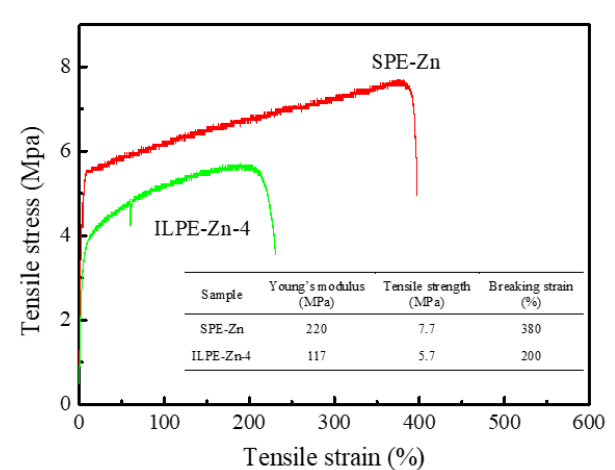
Figure 7. Typical stress-strain curves of SPE-Zn and ILPE-Zn-4 membranes and their mechanical properties (Young’s modulus, tensile strength, and breaking strain).